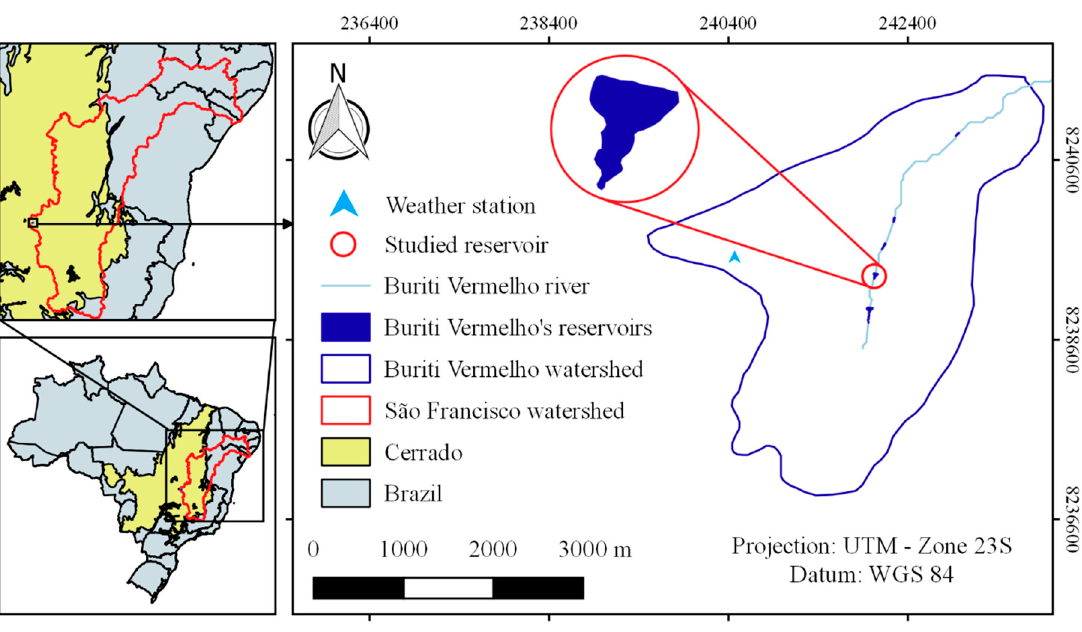
Figure 1. The Buriti Vermelho watershed, Federal District, Brazil, and the small dam used in the study (red circle).